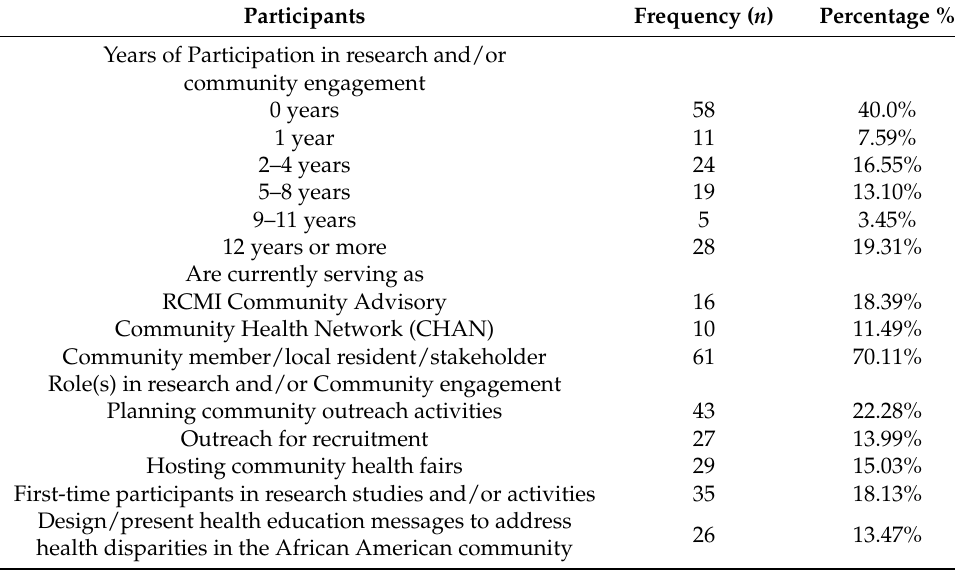
Table 2. Type of research and community engagement